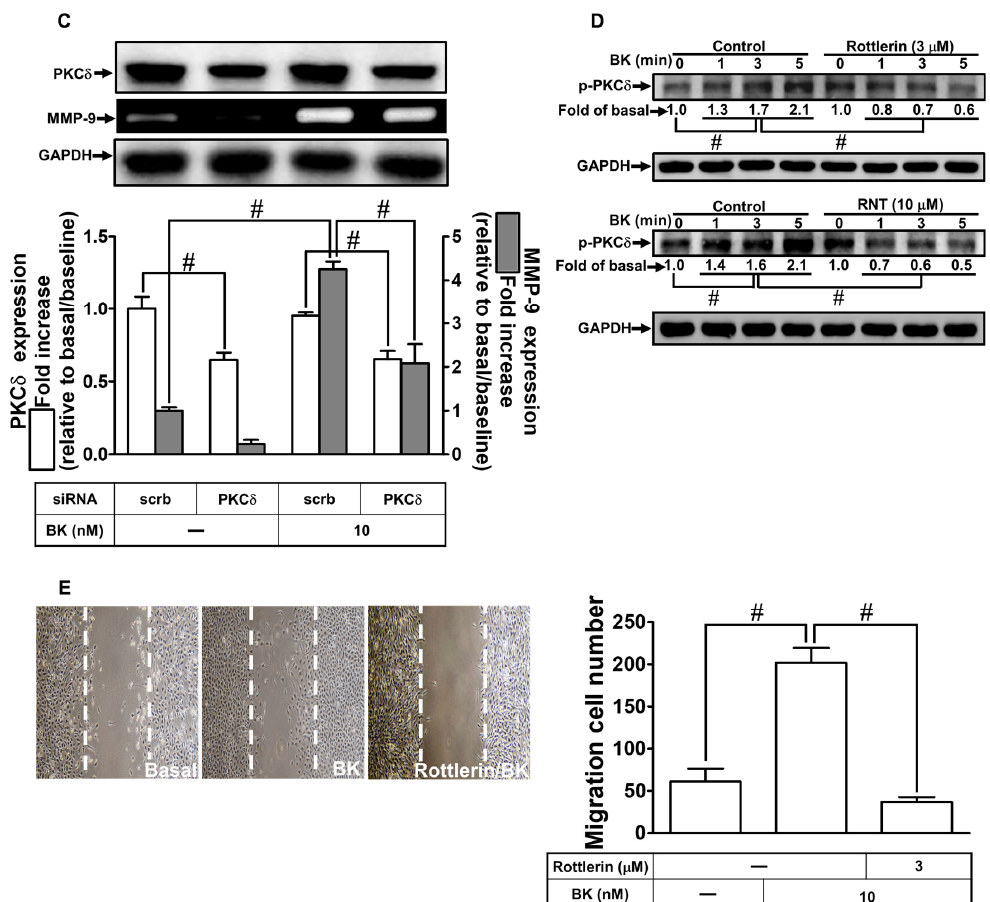
Figure 2. RNT attenuates MMP-9 expression and cell migration induced by BK via regulating PKC δ signaling in RBA-1 cells. ( A ) Cells were pretreated with 3 μ M rottlerin, 10 μ M Ro31-8220, or 10 μ M RNT for 1 h and then stimulated with BK (10 nM) for 16 and 24 h. The levels of MMP-9 in the medium and GAPDH in cell lysates were examined by gelatin zy- mography and Western blot, respectively. ( B ) Cells were pretreated with 3 μ M rottlerin or 10 μ M Ro31-8220 for 1 h and then incubated with BK (10 nM) of 6 h for analyzing MMP-9 mRNA expression and promoter activity, respectively, de- termined by real-time PCR and promoter assay. ( C ) Cells were individually transfected with scrambled (Scrb) or PKC δ siRNA and then incubated with BK (10 nM) for 24 h. The media and cell lysates were collected to determine the levels of MMP-9 by gelatin zymography and the levels of GAPDH and PKC δ by Western blot, respectively. ( D ) Cells were indi- vidually pretreated without or with rottlerin (3 μΜ ) or RNT (10 μ M) for 1 h and then challenged with BK (10 nM) for the indicated time intervals (1, 3, and 5 min). The phosphorylation of PKC δ was determined by Western blot with GAPDH as loading controls. ( E ) Cells were pretreated without or with 3 μ M rottlerin for 1 h and then incubated with BK (10 nM) for 48 h. The number of migratory cells was determined (magnification = 40×). Data are expressed as mean ± SEM of three independent experiments. # p < 0.01 as compared with the cells exposed to vehicle or BK, as